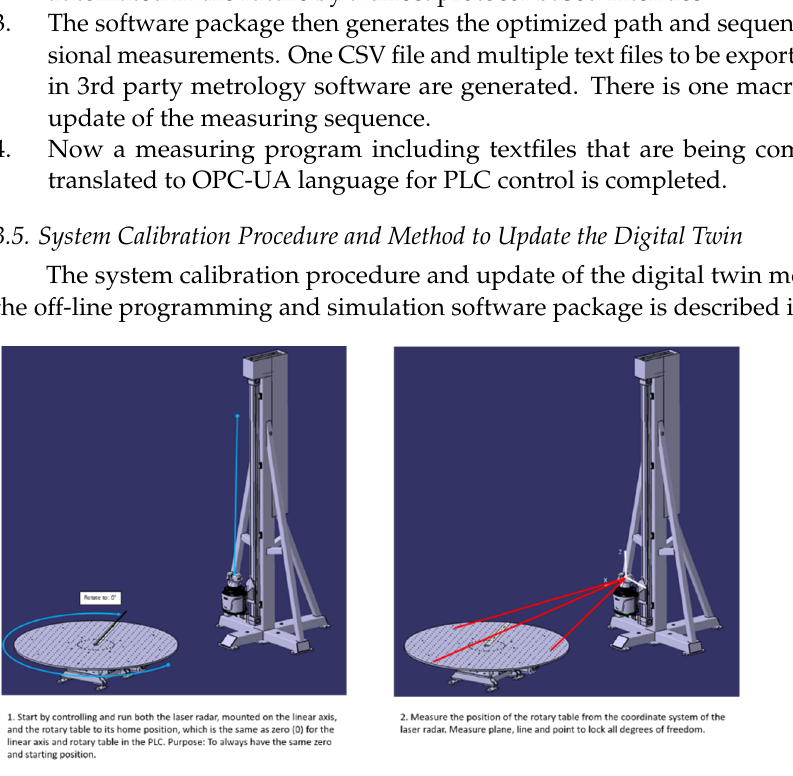
Figure 22. General description of the data and information process acting in the measuring cell. Starting with off-line programming, including path planning and sequence optimization. Then a complete dimensional metrology program is generated by scripts.